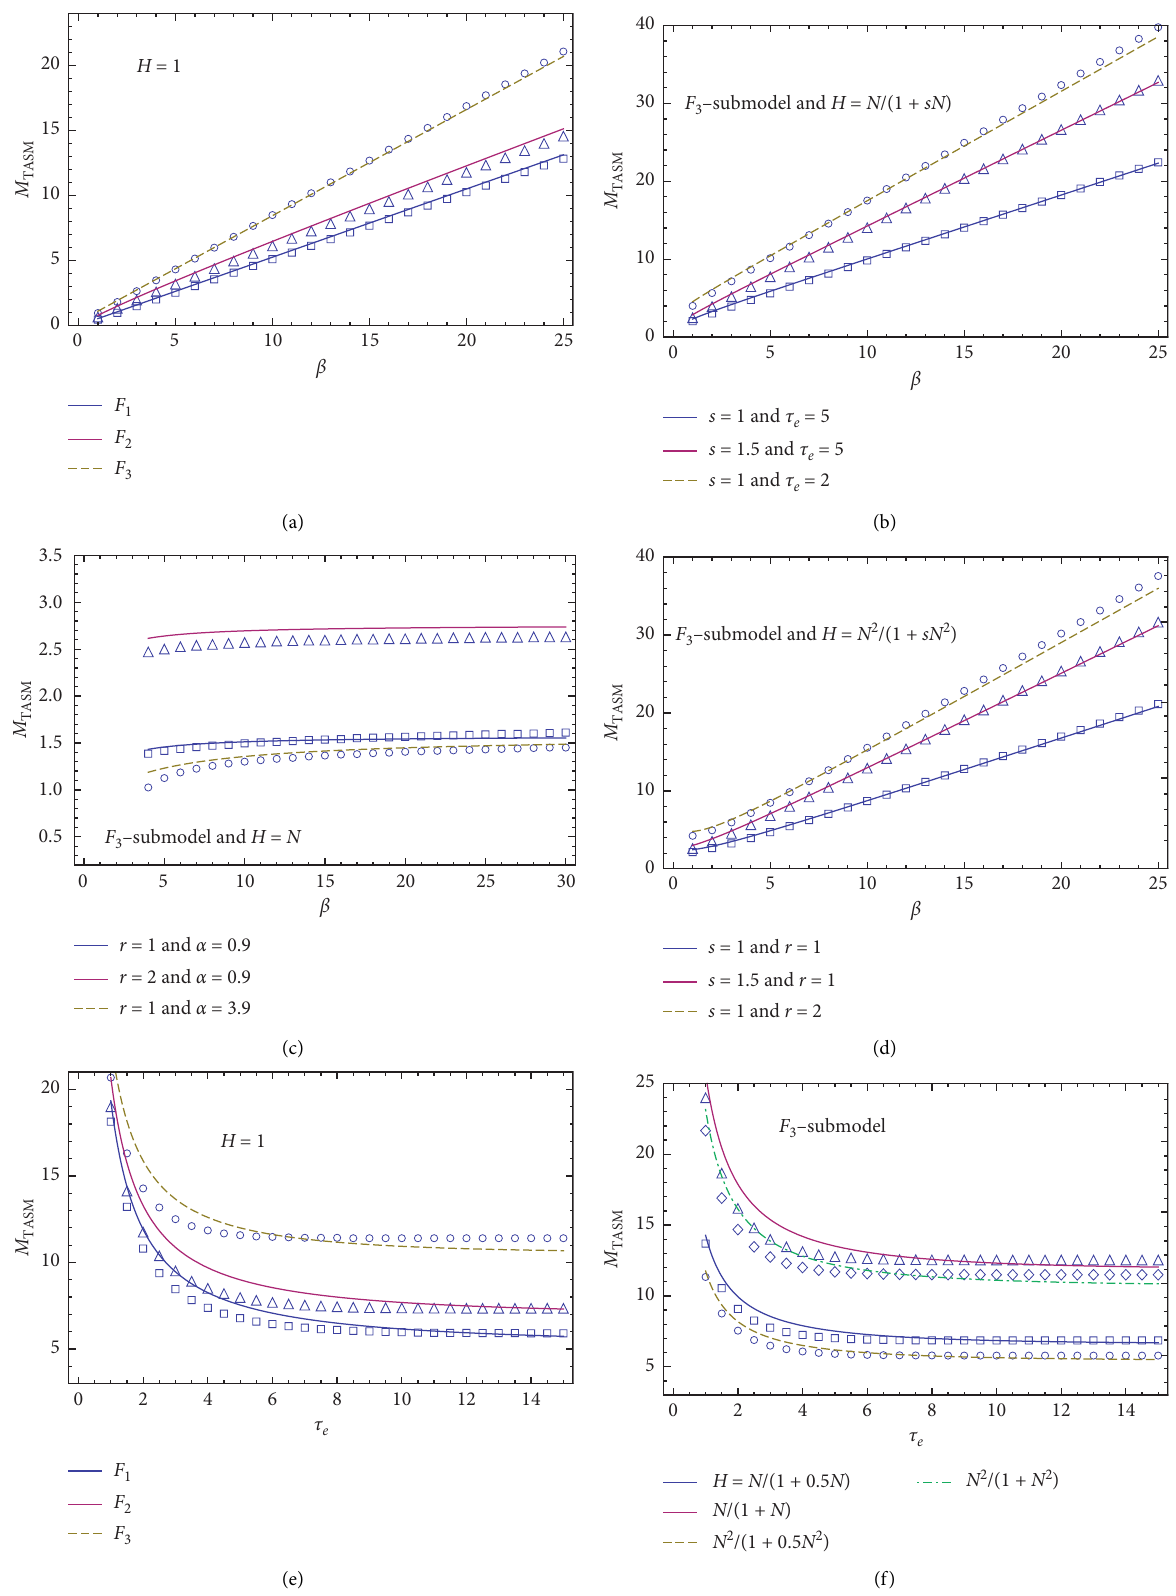
Figure 3: Theoretical and simulated M , in the case of single mass release strategy, as a function of β and as a function of τ e . The TASM remaining parameters values are δ � 1, c � 0 . 5, and p � 13. (a) Parameters values are as follows: r � 1, τ s � 8, τ e � 5, and α � 0.8, (b) parameters values are as follows: r � 1, τ s � 8, and α � 0.8, (c) parameters values are as follows: τ s � 8 and τ e � 6, (d) parameters values are: τ e � 5, τ s � 8, and α � 0.8, (e) parameters values are as follows: r � 1, τ s � 15, β � 15, and α � 0.8, (f) parameters values are as follows: r � 1, τ s � 15, β � 15, and α �